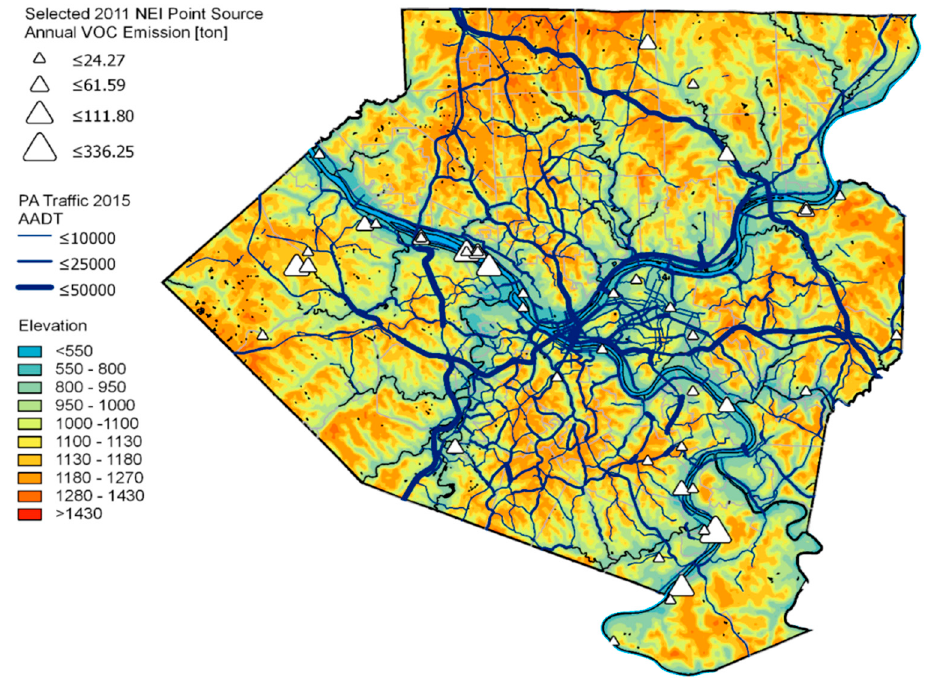
Figure 3. Map of elevation above sea level (in feet), major roads and major VOC point source facilities in Allegheny County. AADT = Annual Average Daily Traffic counts.